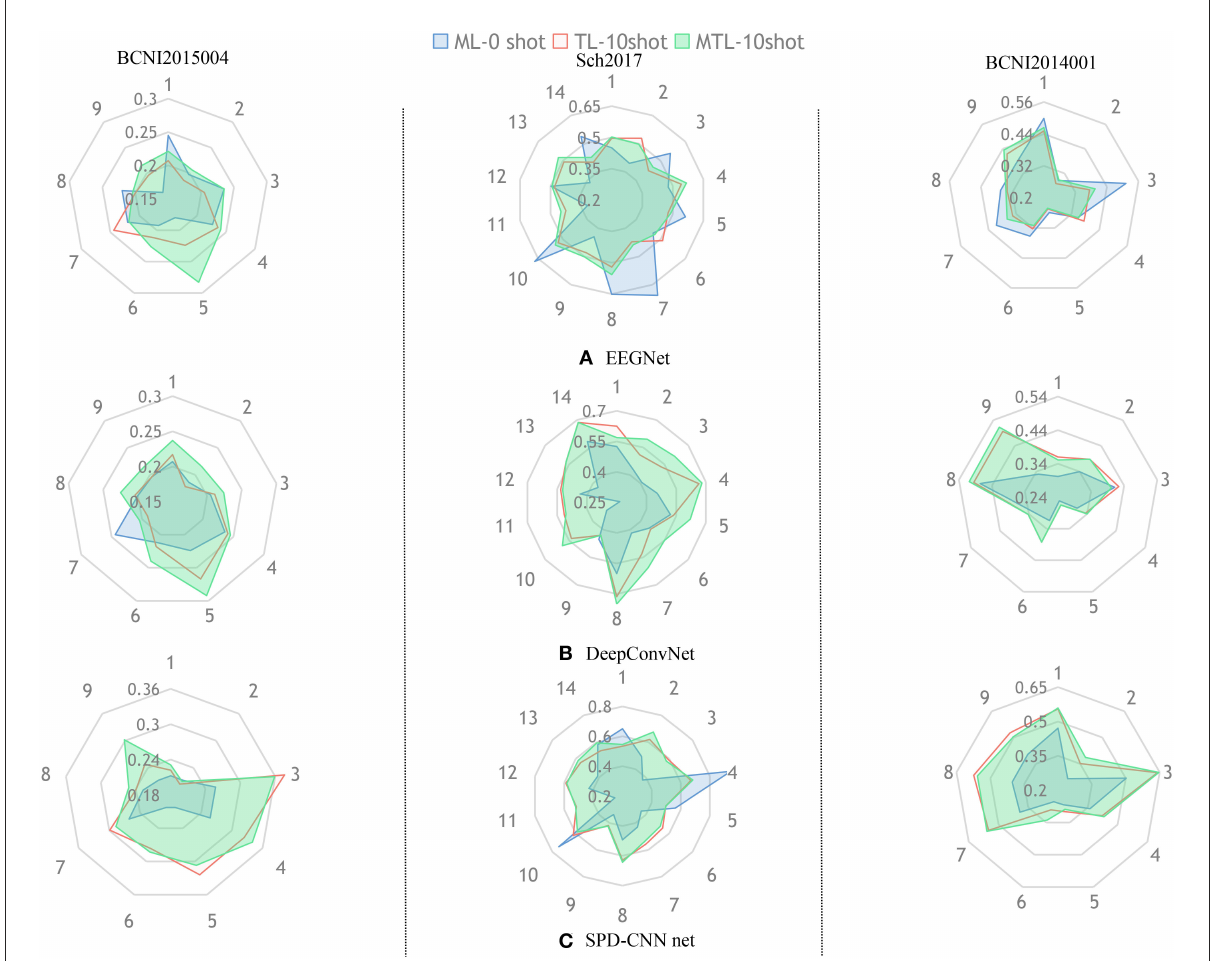
FIGURE5 The aim of this radar picture is to show the different performances using different training methods and different colors represent different training strategies (Blue:ML,Red:TL,Green:MTL).The three subgraphs (A–C) represent the classification performance of the three models,